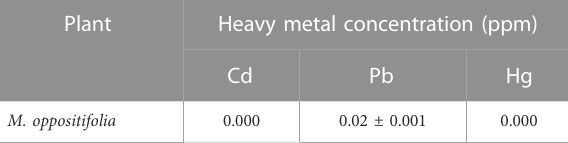
TABLE 1 Heavy metals content in M. oppositifolia determined by AAS.